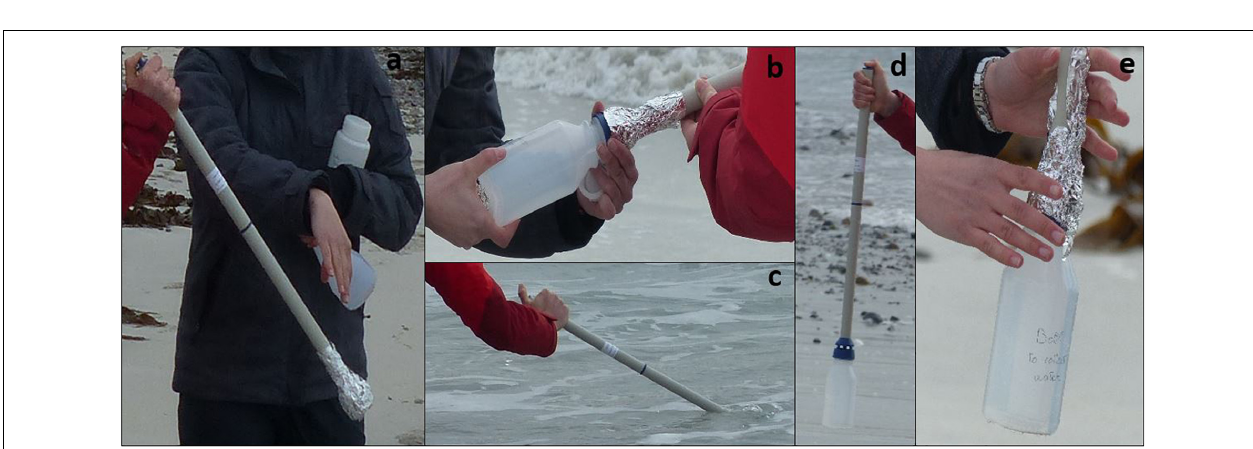
FIGURE 4 | Demonstration of sediment collection using a glass bijou jar as a scoop (a,b) with a dampened filter paper (c) to assess air contamination during the sampling.